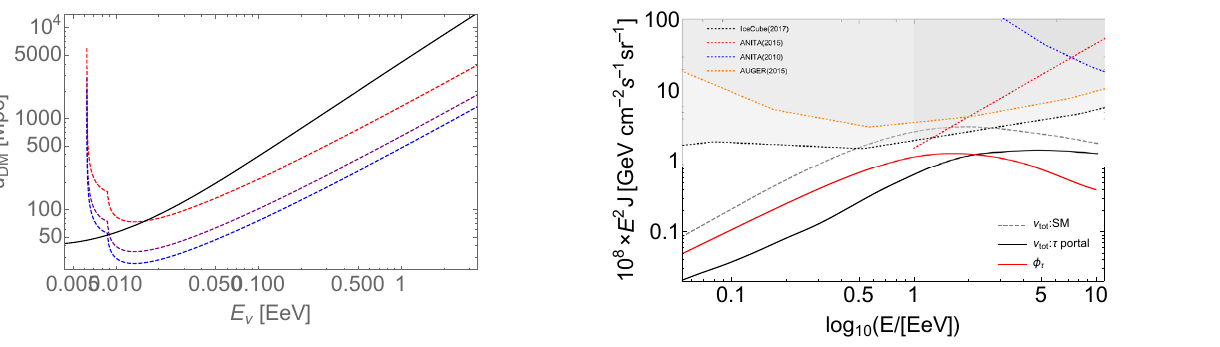
M ψ = 15 MeV and τ (cid:31)